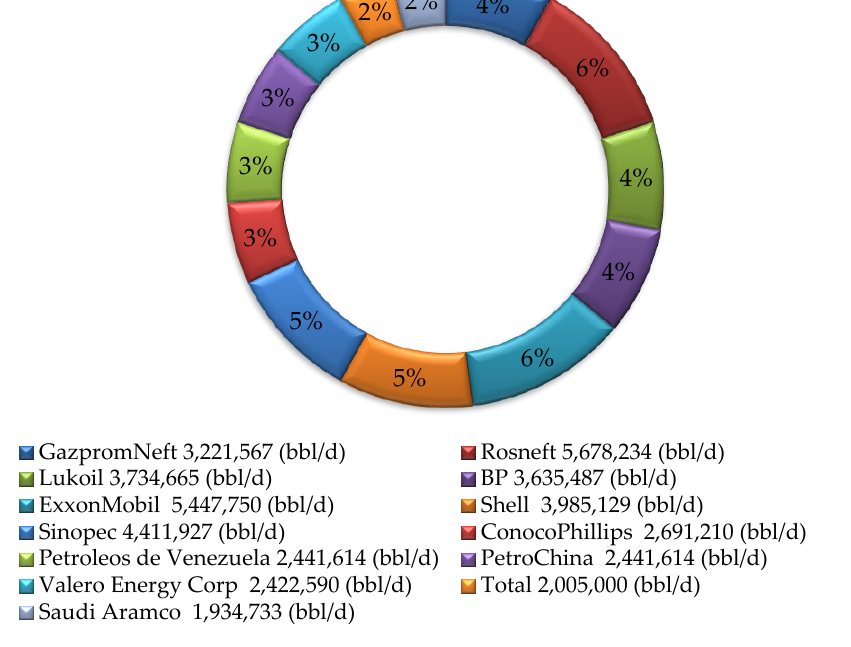
Figure 4. Top 12 refining companies by capacity in bbl/d.